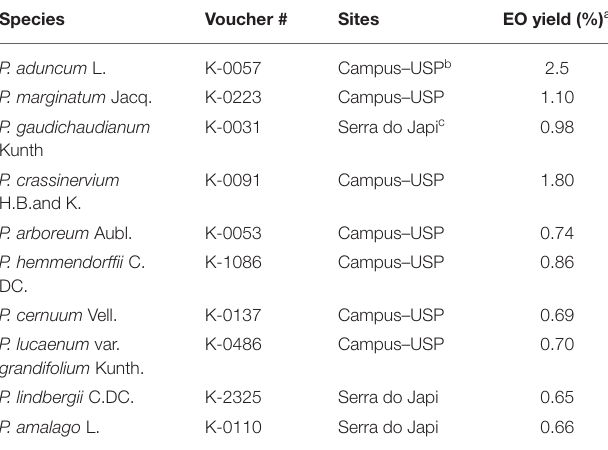
TABLE 1 | Voucher number, sampling site, and yield of essential oil from Piper species.